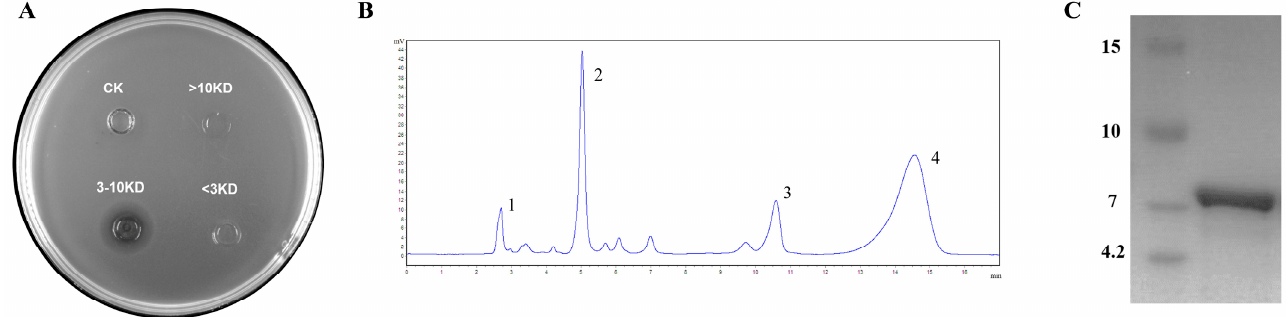
Figure 3. Purification of Bacteriocin. ( A ) Ultrafiltration tubes separate the active fractions. ( B ) RP- HPLC process of purification. ( C ) Tricine–SDS–PAGE of activity fraction.